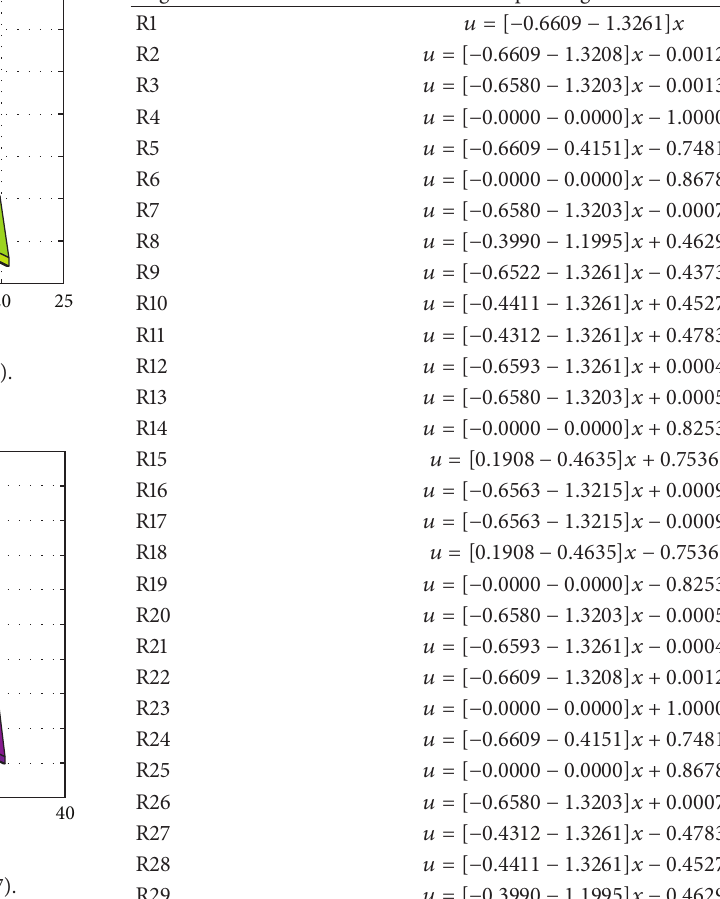
Figure 10: The partitions of feasible set X 3 7 ( 𝑁 = 7 ).